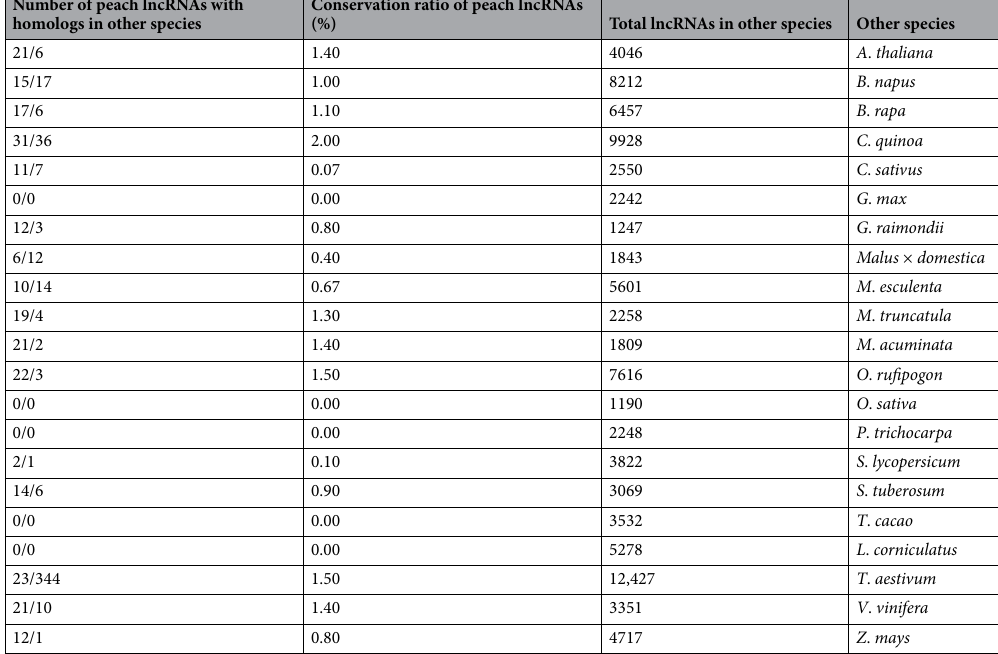
Table 2. Identification of conserved lncRNAs in other plant species from the NONCODEv6